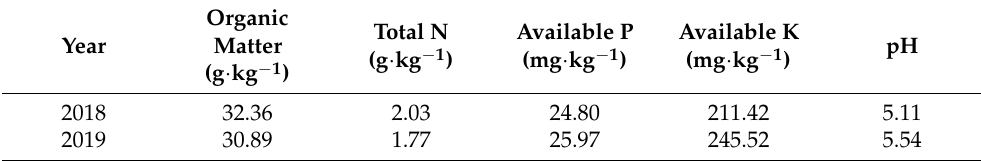
Table 1. Chemical properties of the soil at the study sites.